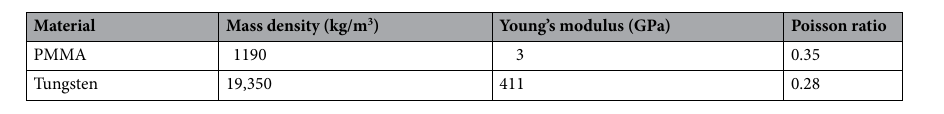
Table 1. The elastic properties of rod and background materials of proposed phononic crystal fiber.